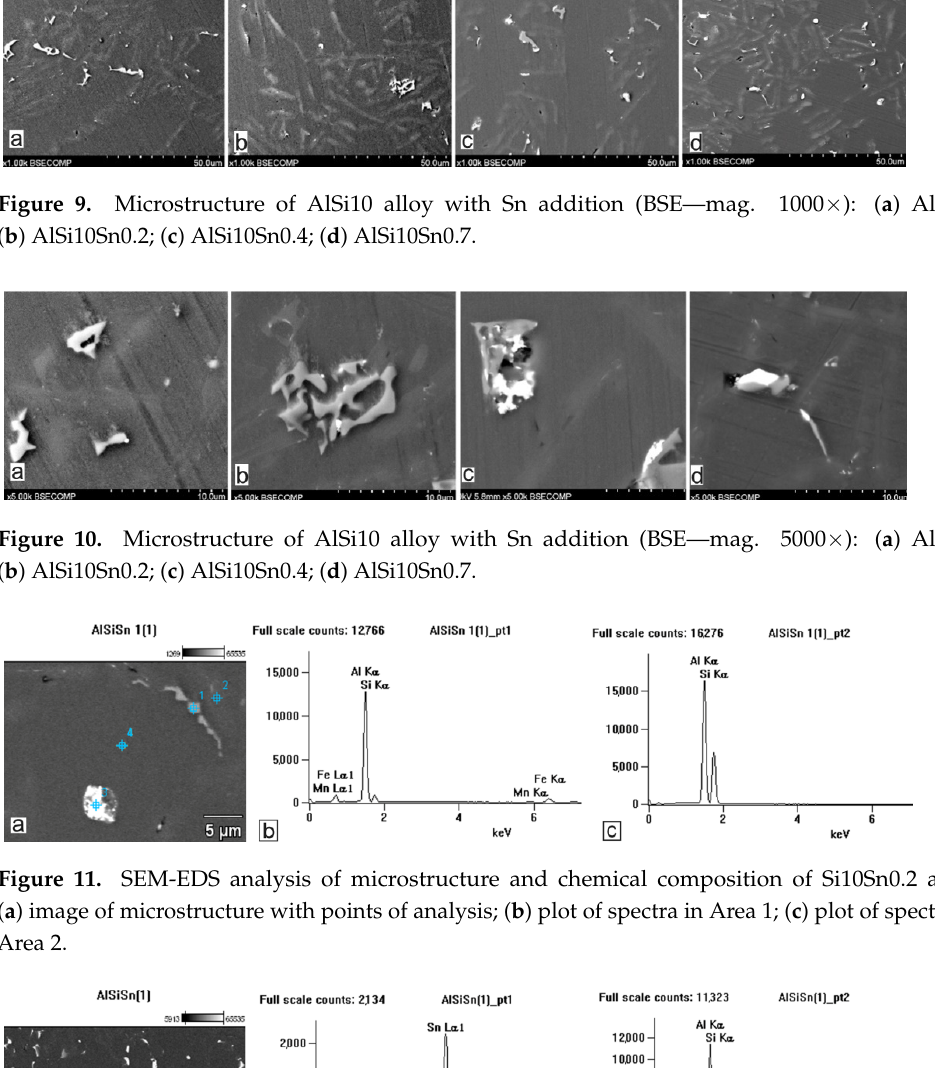
( d ) Figure 13. SEM-EDS analysis of microstructure and chemical composition of Si10Sn1.7 alloy (ele- ment distribution map—mag. 1000×): ( a ) image of microstructure; ( b ) Al; ( c ) Si; ( d ) Sn. Table 6. Chemical composition of AlSi10Sn0.2 alloy in micro area from Figure 11. Sample - - Table 7. Chemical composition of AlSi10Sn1.7 alloy in micro area from Figure 12. Sample